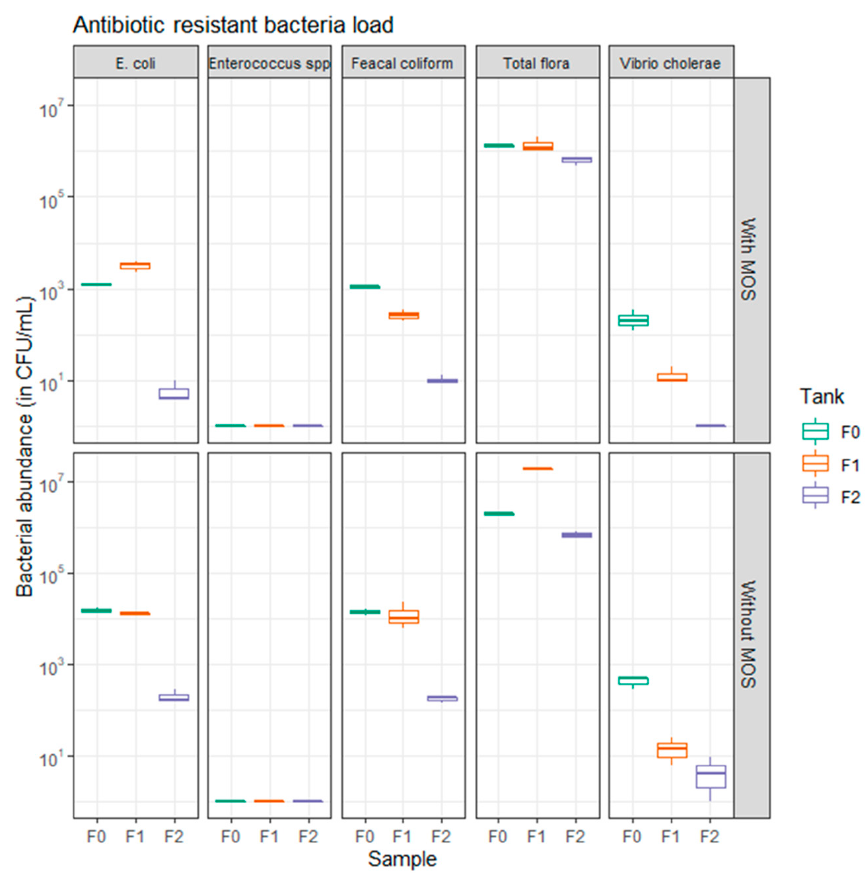
Figure 4. Abundances of antibiotic-resistant bacteria in samples taken at the entrance of each tank for evaluation of abatement; counted number of bacteria represented as log 10 reduction.